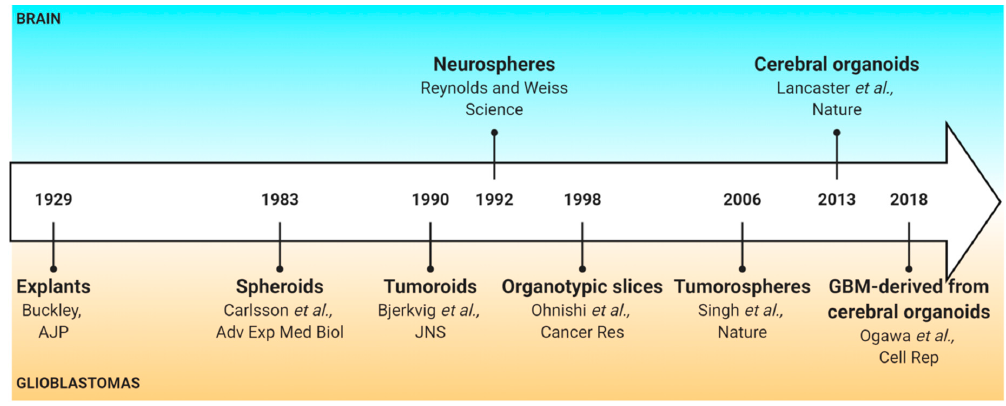
Figure 1. History of pioneer papers on 3D human glioblastoma models.